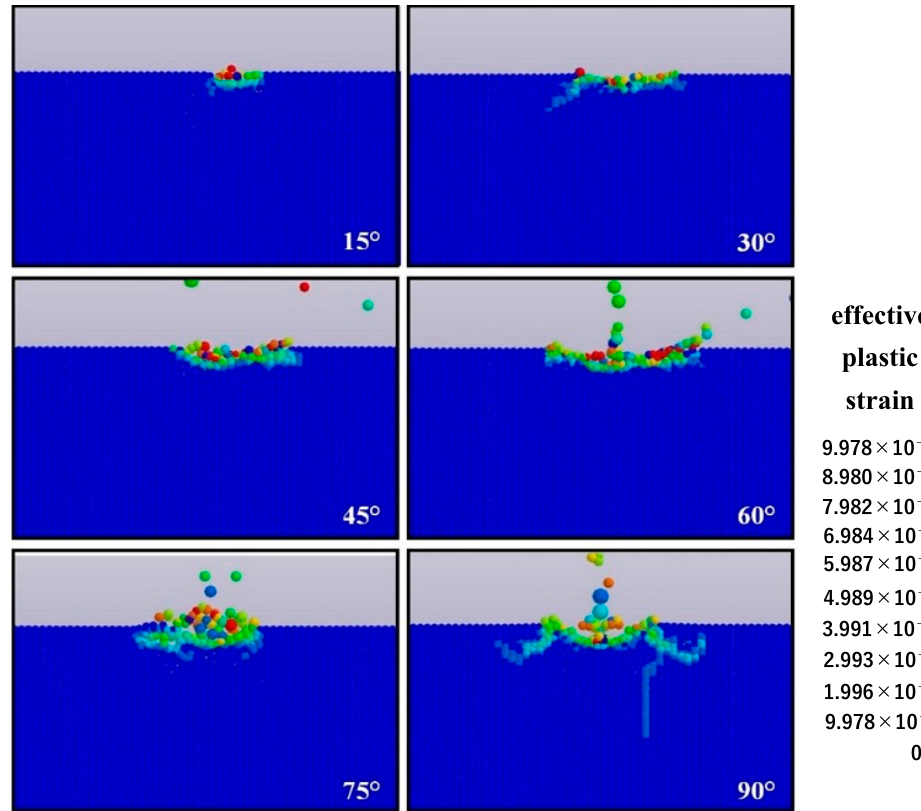
Figure 9. Surface morphology of impacted optical glass under different impact angles.